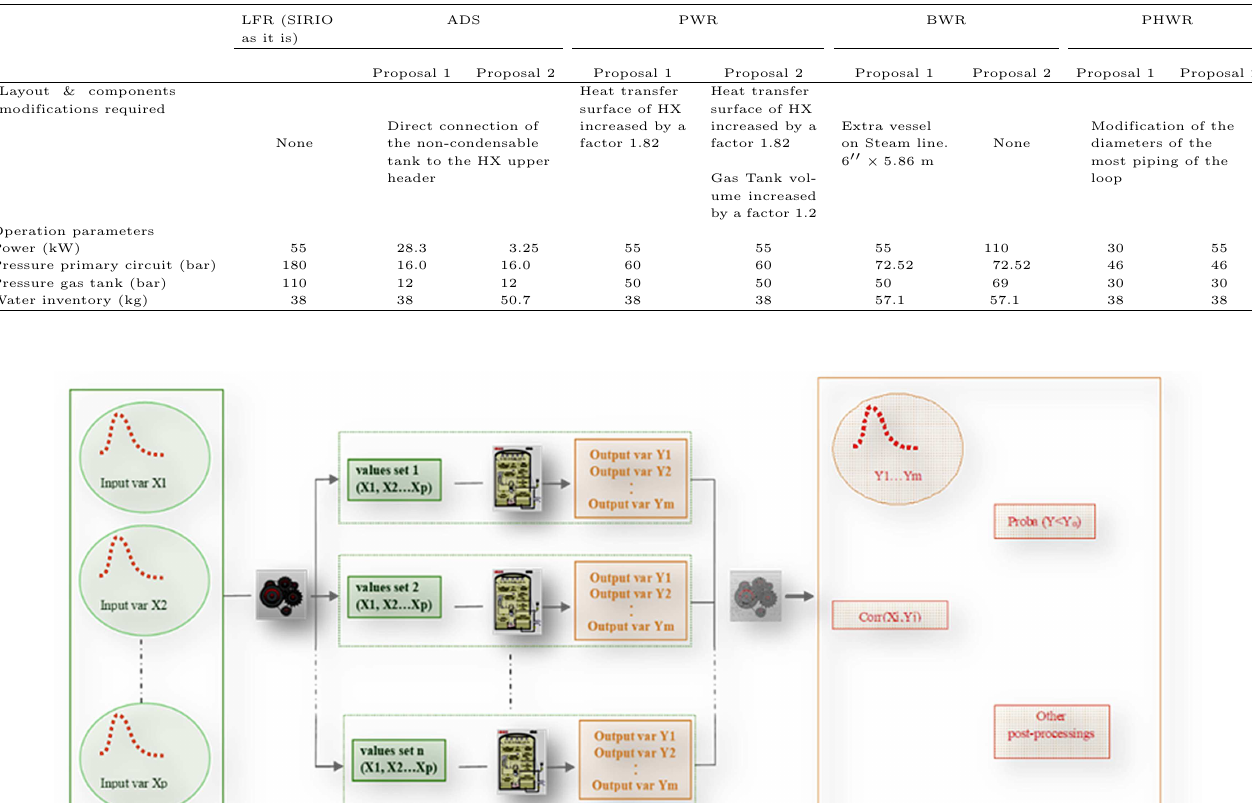
Table 1. Tests conditions for SIRIO experimentation.